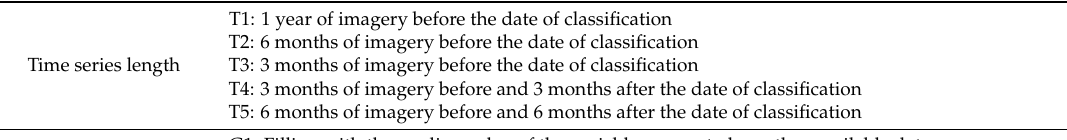
Table 3. Different methodological options tested to classify the landscape along the year based on a more detailed level of nomenclature (Level